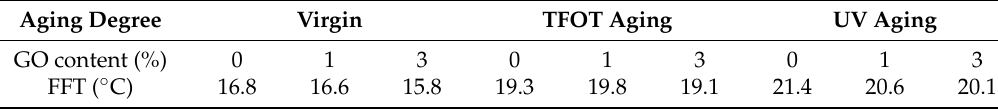
Figure 14. Fatigue cracking factor of SBS MA and GO-modified SBS MA. Table 3. The FFT of the SBS MA and GO-modified SBS MA. Aging Degree Virgin TFOT Aging